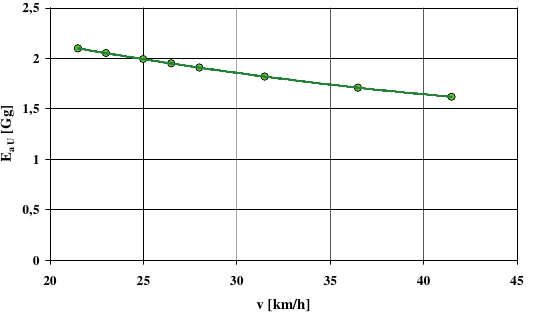
Fig. 20. Dependence of the national annual emission of carbon dioxide from passenger cars upon the average velocity, under model conditions of rural